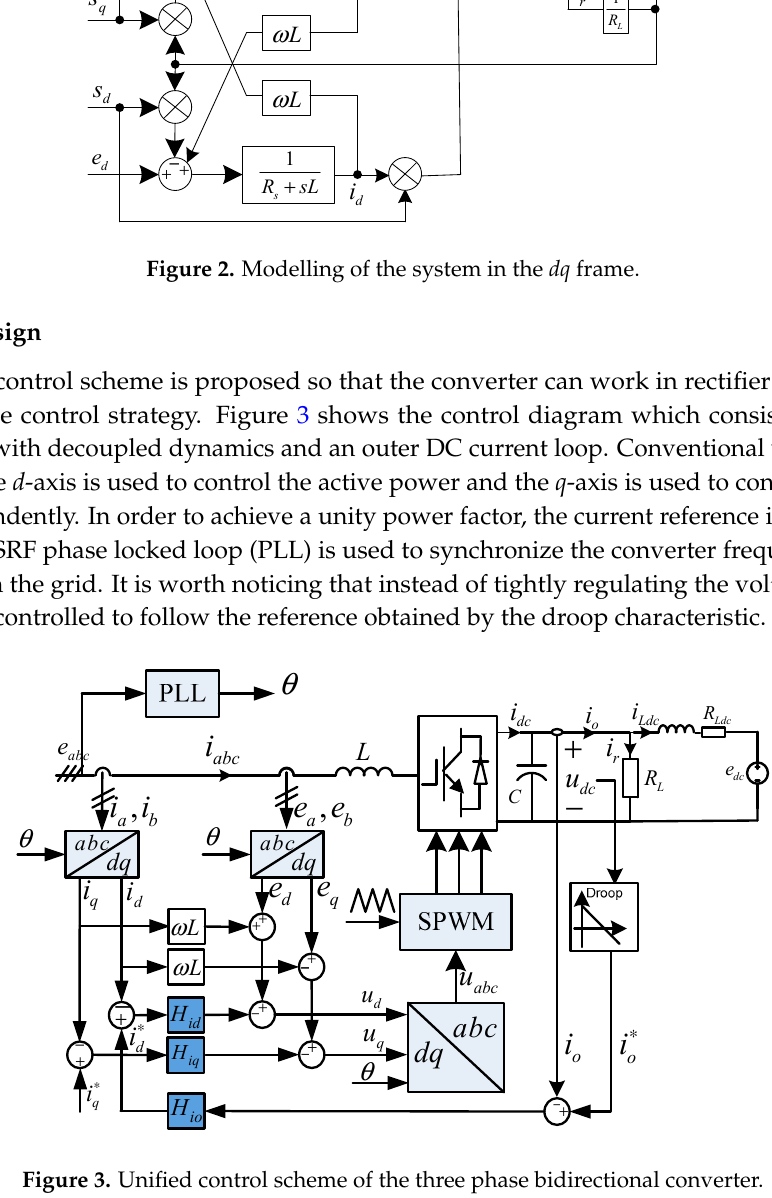
Figure 4. Inner current control loop diagram for the (cid:1856) -axis.